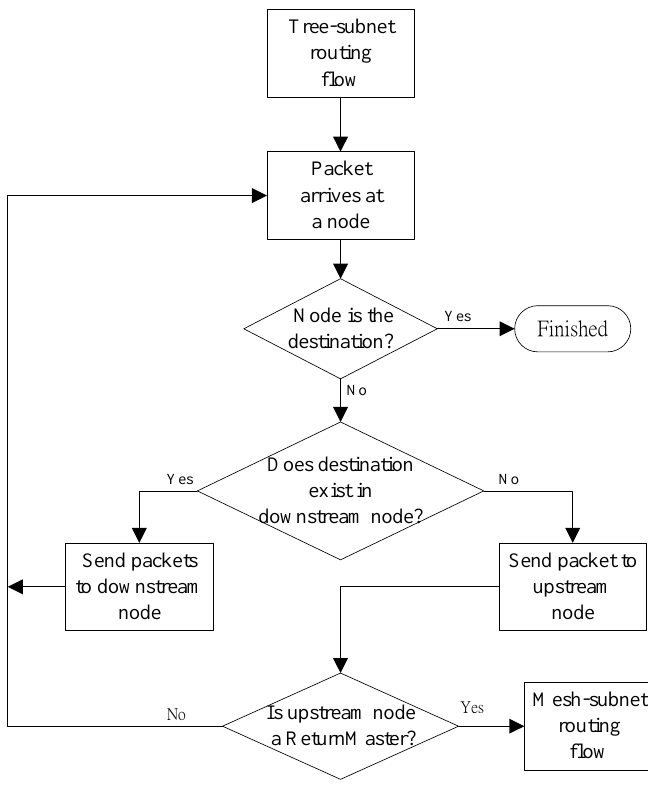
Figure 8. Tree-subnet routing flow diagram.